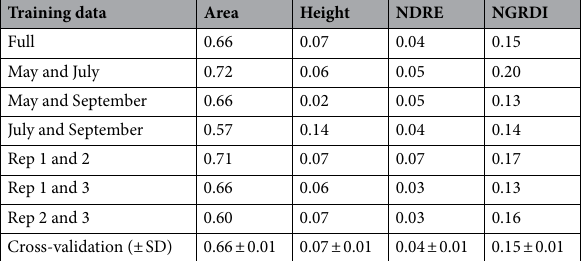
Table 2. Regression coefficients of prediction models trained with different sets of data. SD standard deviation (100